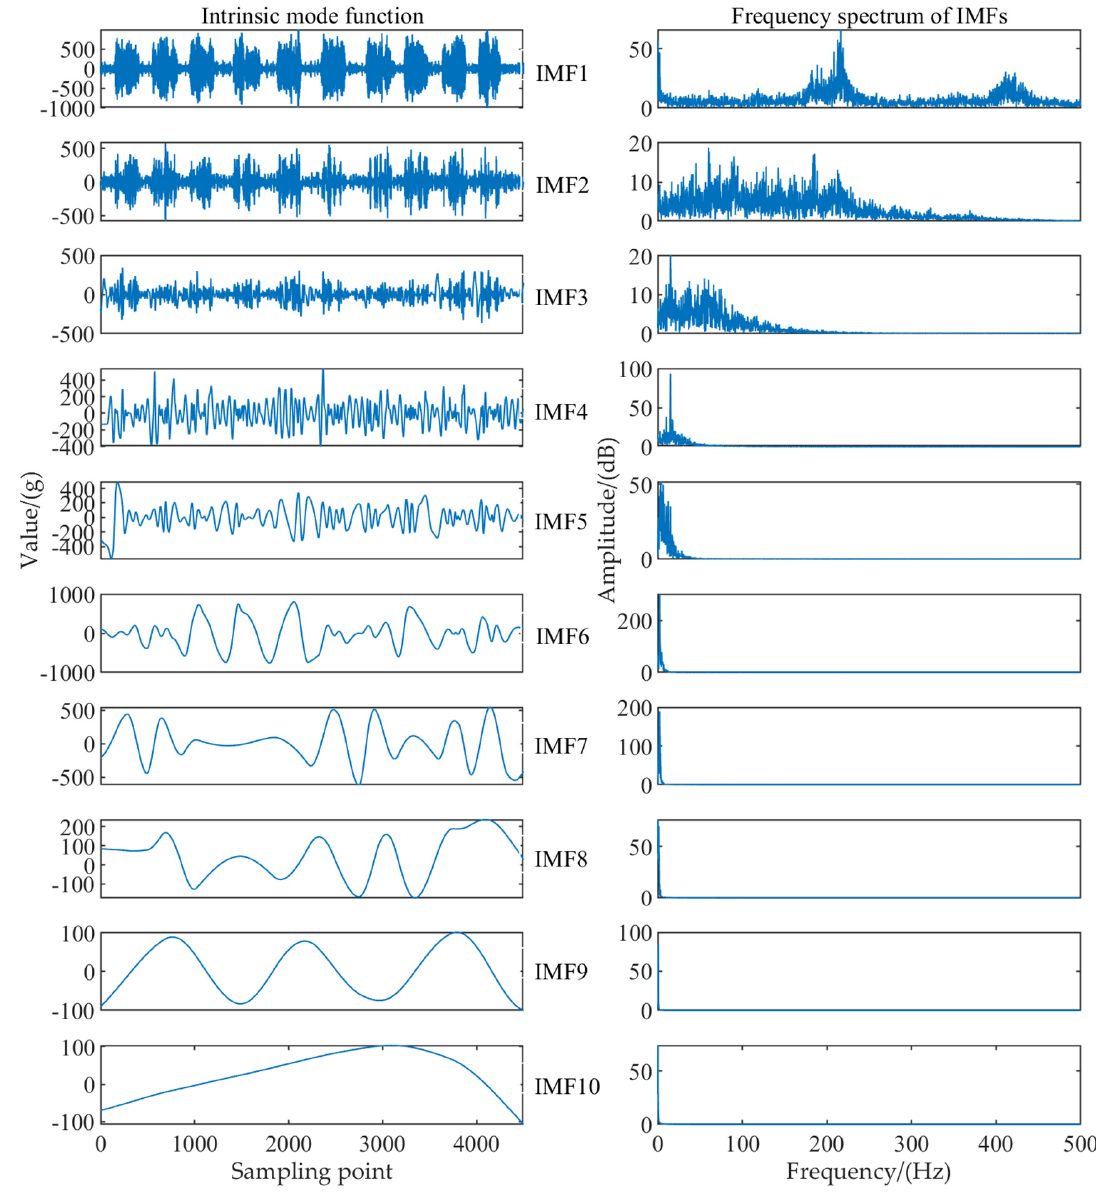
Figure A3. Decomposition result of the EMD method.